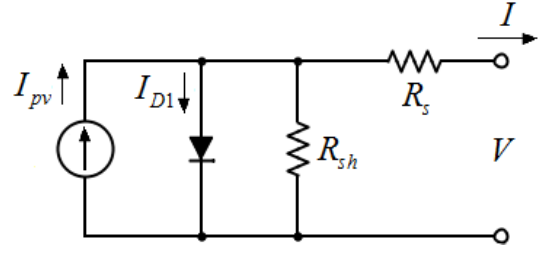
Figure 1. Solar cell/panel 1-diode/2-resistor equivalent circuit model [1].